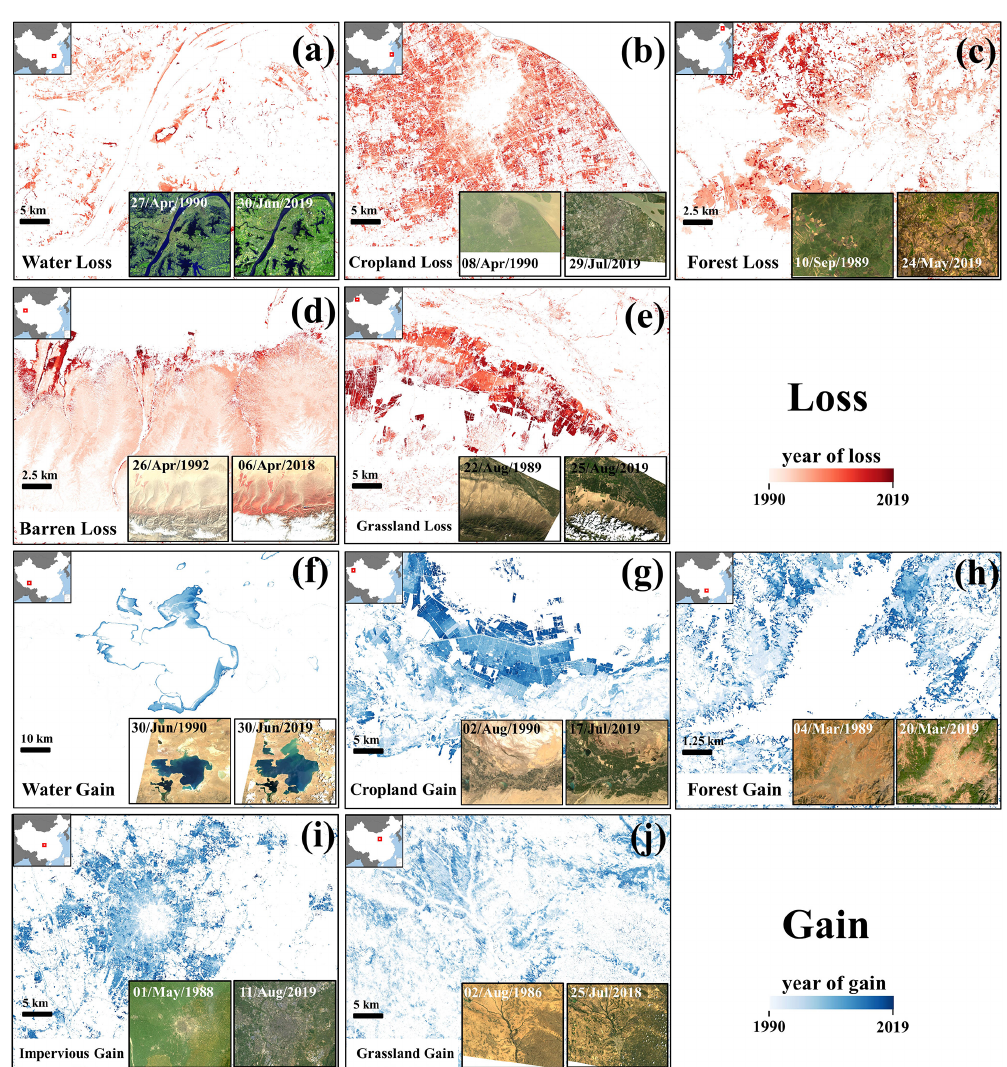
Figure 13. Typical land cover changes and conversions observed in China from 1985 to 2019: (a) lake shrinkage in Wuhan city (30.543703 ◦ N, 114.296992 ◦ E); (b) cropland loss due to the urbanization in Shanghai city (31.214542 ◦ N, 121.490796 ◦ E); (c) defor- estation induced by reclamation in northeast China (49.627007 ◦ N, 125.029041 ◦ E); and (d) bare land converted to grassland in the Qira oasis, located at the southern fringe of the Taklamakan Desert (36.237807 ◦ N, 81.215592 ◦ E). The illustration is of Landsat im- ages with false-colour combination (red: NIR, green: red, blue: green) to enhance the grassland; (e) grassland loss due to the reclama- tion in northwest China (43.575843 ◦ N, 80.987817 ◦ E); (f) Siling Co Lake (also known as Siling Lake) expansion in the Tibetan Plateau (31.793826 ◦ N, 89.057216 ◦ E); (g) reclamation in the Aksu Prefecture (40.593062 ◦ N, 81.048109 ◦ E); (h) afforestation in Yunnan Province (26.518645 ◦ N, 103.613297 ◦ E); (i) expansion of Chengdu city (30.666955 ◦ N, 104.068452 ◦ E); (j) grassland gain in the Mu Us Desert, Yulin city (38.509526 ◦ N, 109.660052 ◦